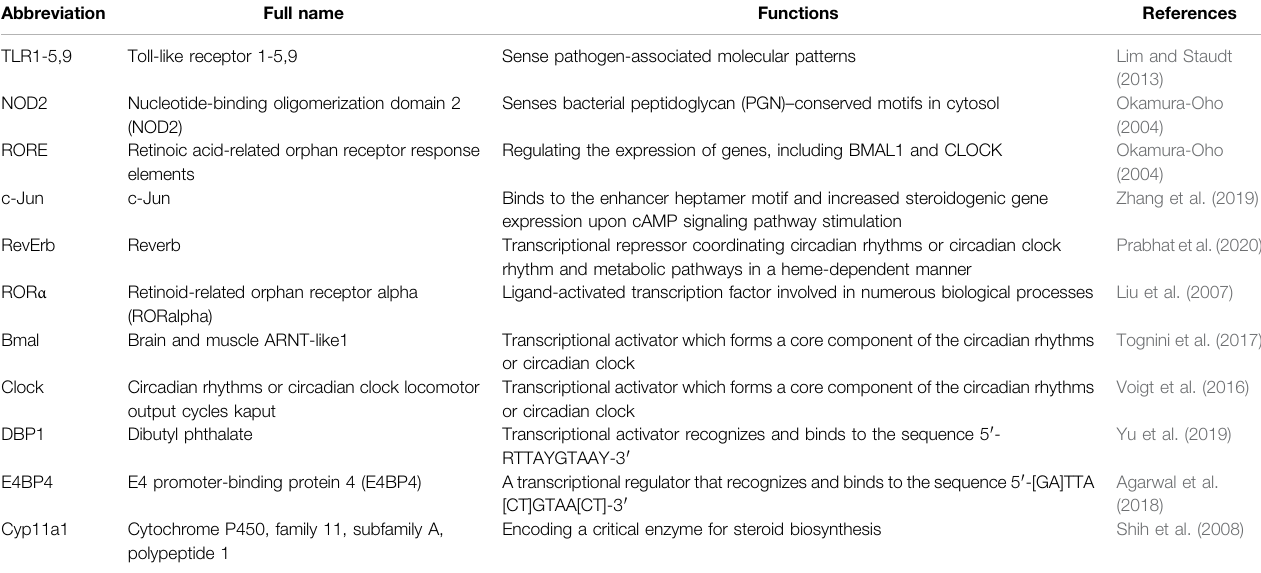
TABLE 4 | Relative molecules involved in circadian rhythm